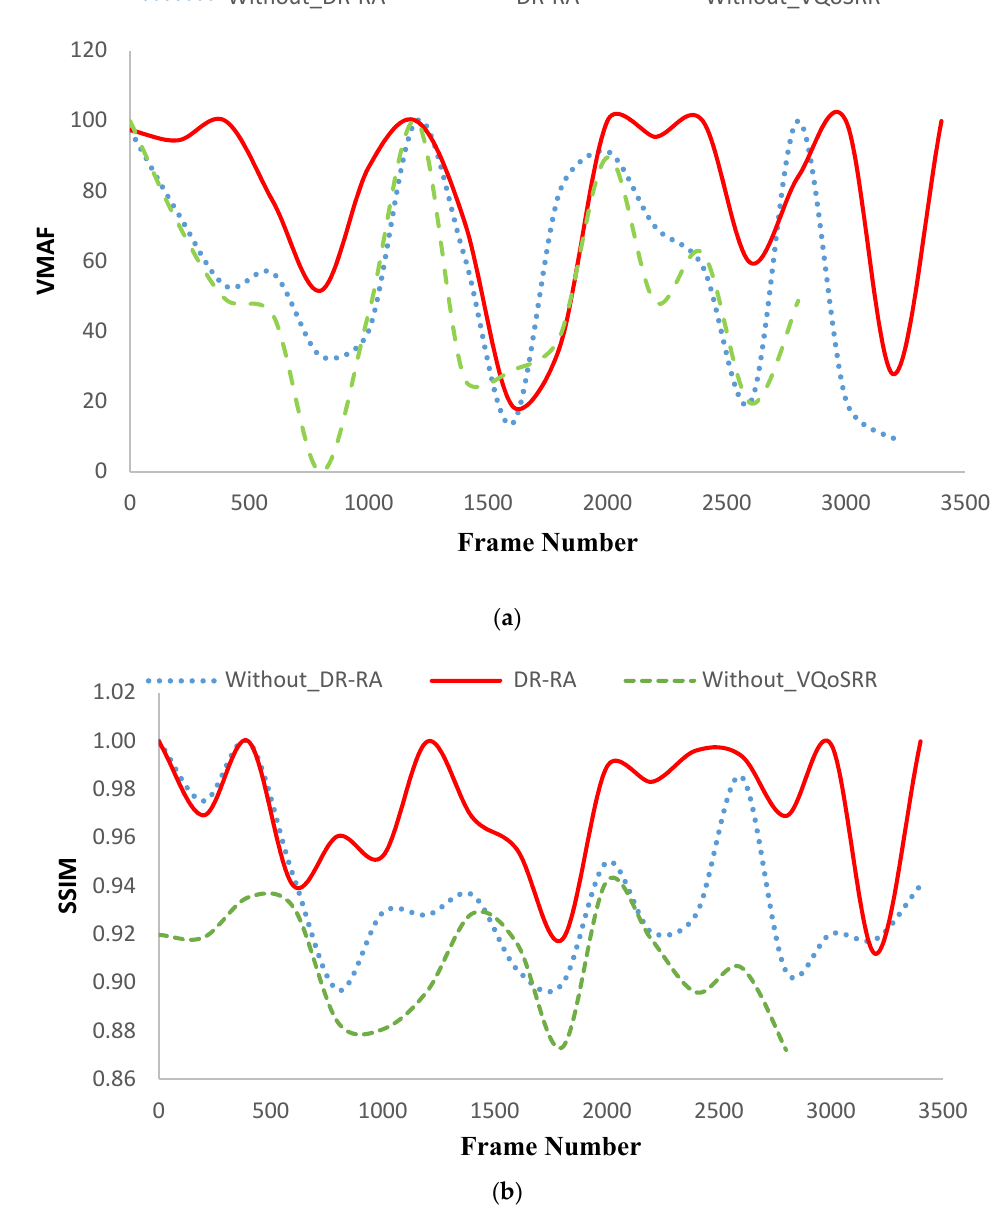
Figure 7. Comparison when using DR-RA, without DR-RA, and without the proposed VQoSRR. ( a ) Comparison of VMAF; ( b ) comparison of SSIM metrics.